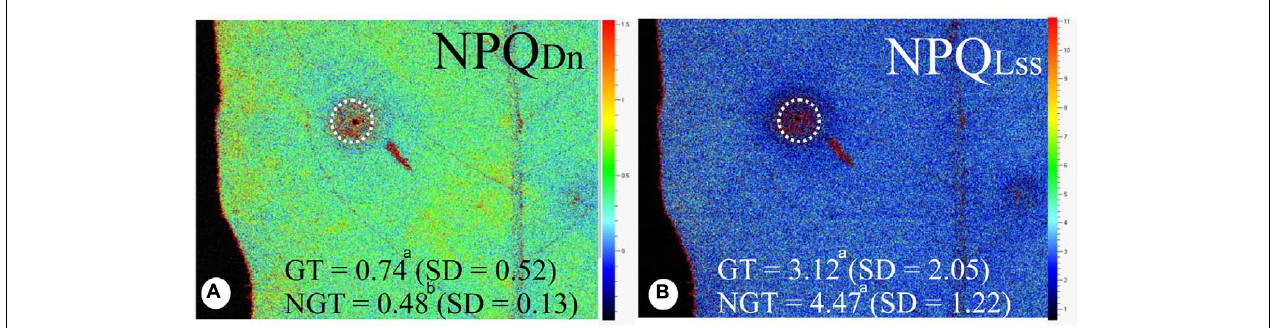
FIGURE 4 | Fluorescence quenching analysis performed in non-galled tissues of Matayba guianensis (Sapindaceae) and in galls induced by Bystracoccus mataybae (Eriococcidae) using a modulated fluorescence imaging apparatus (Handy Fluorcam PSI – Photo Systems Instrument, Czech Republic). (A) Imaging of NPQ DN (instantaneous non-photochemical quenching during dark relaxation). (B) Imaging of NPQ Lss (steady-state non-photochemical quenching). GT, galled tissue; NGT, non-galled tissue; SD, standard deviation. Values followed by the different letters differ significantly by the Wilcoxon